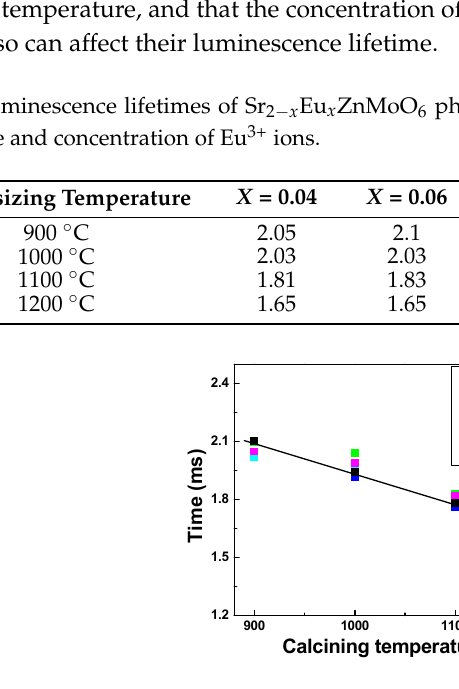
Table 1. Luminescence lifetimes of Sr 2 − x Eu x ZnMoO 6 phosphors as a function of the synthesizing temperature and concentration of Eu 3+ ions.